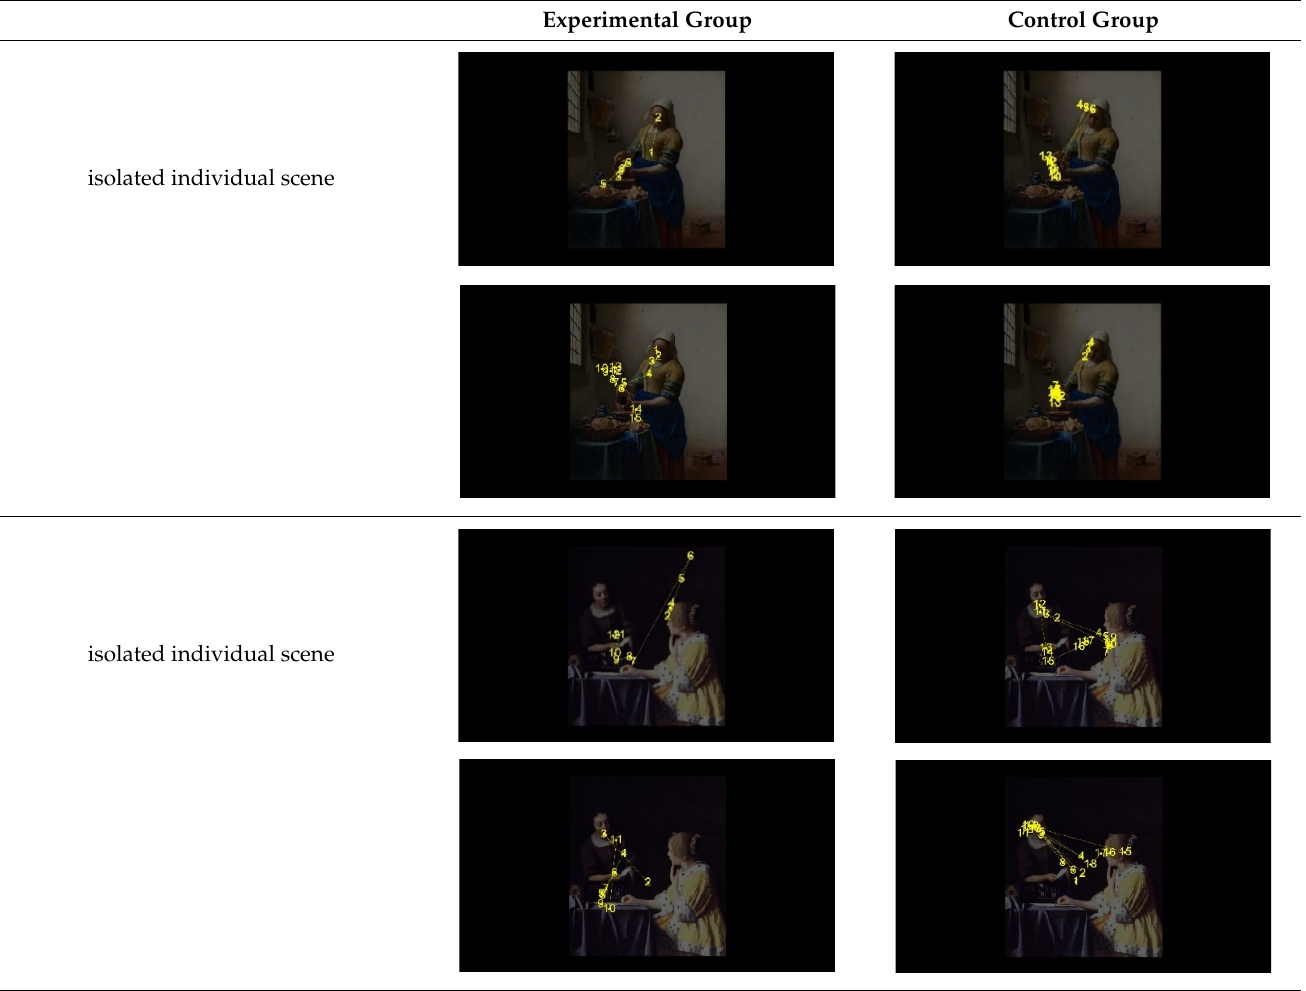
Table 5. Eye tracking diagrams of experimental group (autistic children) and control group (TD children) looking at different scenes.